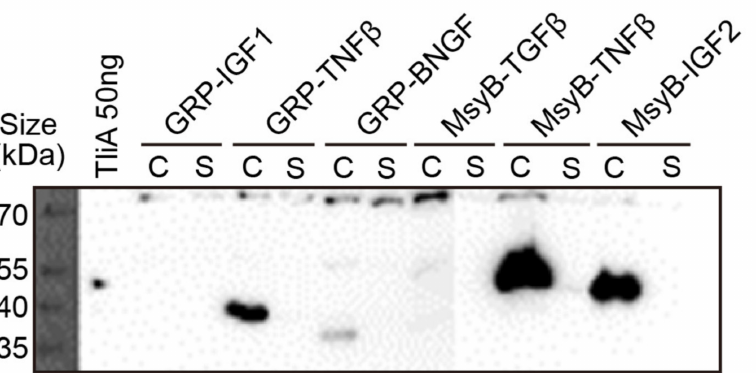
Figure A5. The N-terminal fusion of acidic proteins could not rescue the secretion of non-secretable proteins. Two different very anionic (acidic) proteins, Arabidopsis thaliana glycine-rich protein (GRP, pI = 3.07) and E. coli MsyB (pI = 3.60), were attached to multiple different cationic (basic) proteins. None of them could rescue the secretion of these proteins, as clearly shown in all the samples. All the target proteins were localized in the cell pellet portions (“C”), and no signal was detected in the culture supernatant portions